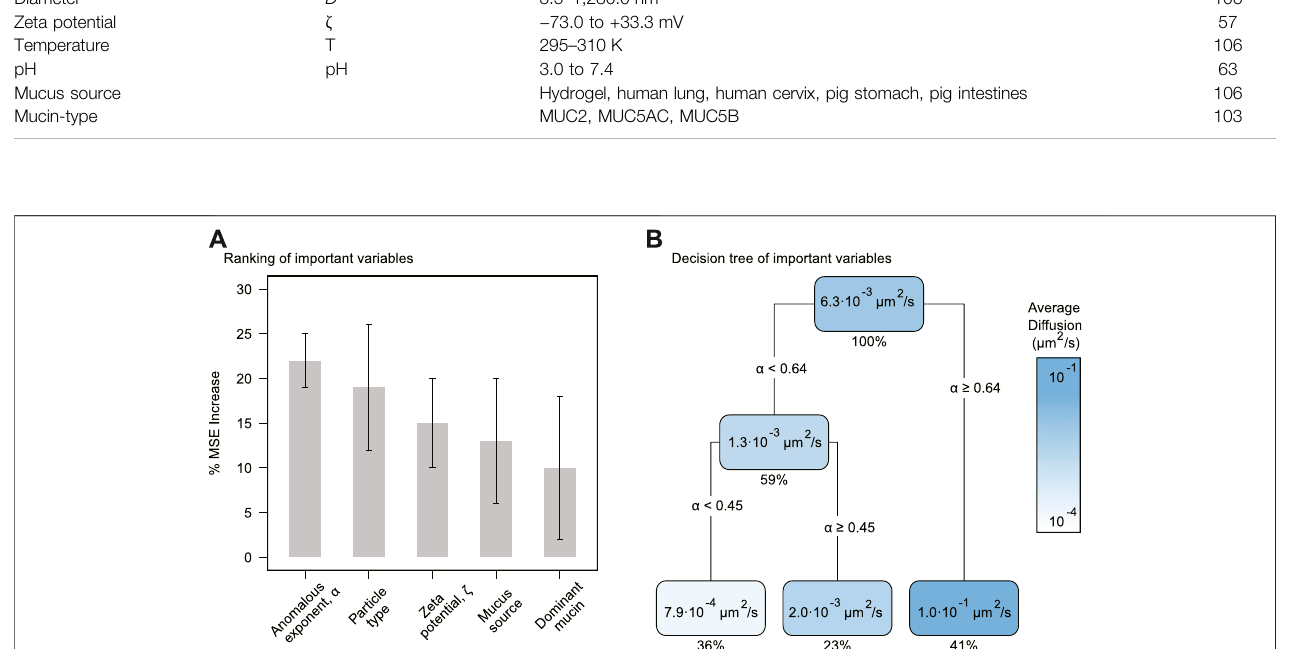
FIGURE 1 | Selected variables impacting effective diffusion. (A) Average percentage increase of mean-squared error ( % MSE) for the selected variables. The error bars correspondtothestandarddeviation. (B) Decisiontreeforthemostimportant variables. Each node contains thepredicted average D eff and thepercentage ofdata predicted. The gradient display diffusion values from ∼ 10 – 4 μ m 2 /s (white) to ∼ 10 – 1 μ m 2 /s (blue).